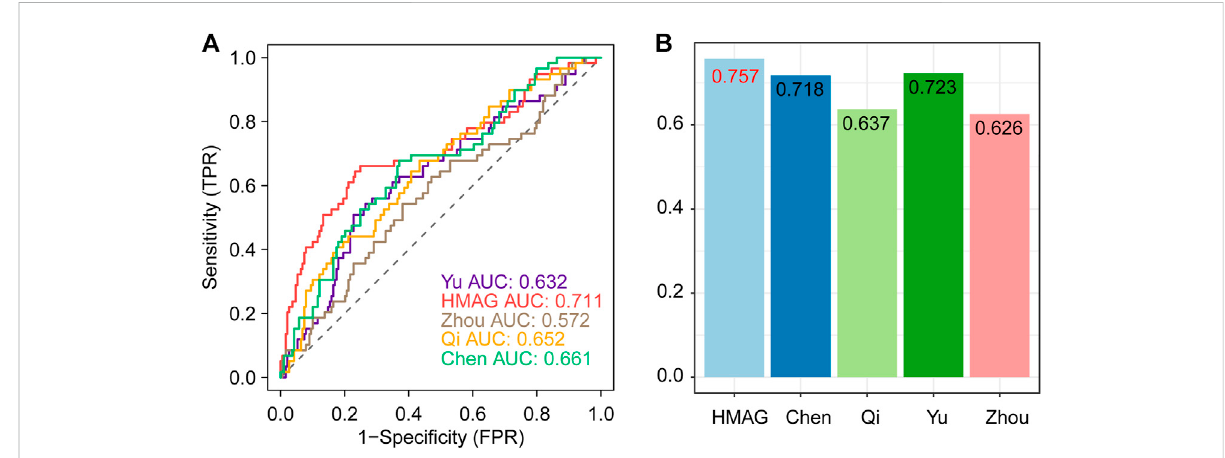
FIGURE 8 Comparison of the prognostic value between HMAG and proposed signatures. (A) ROC curves showing the prognostic value of fi ve signatures and (B) C-index showing the prognostic value of fi ve